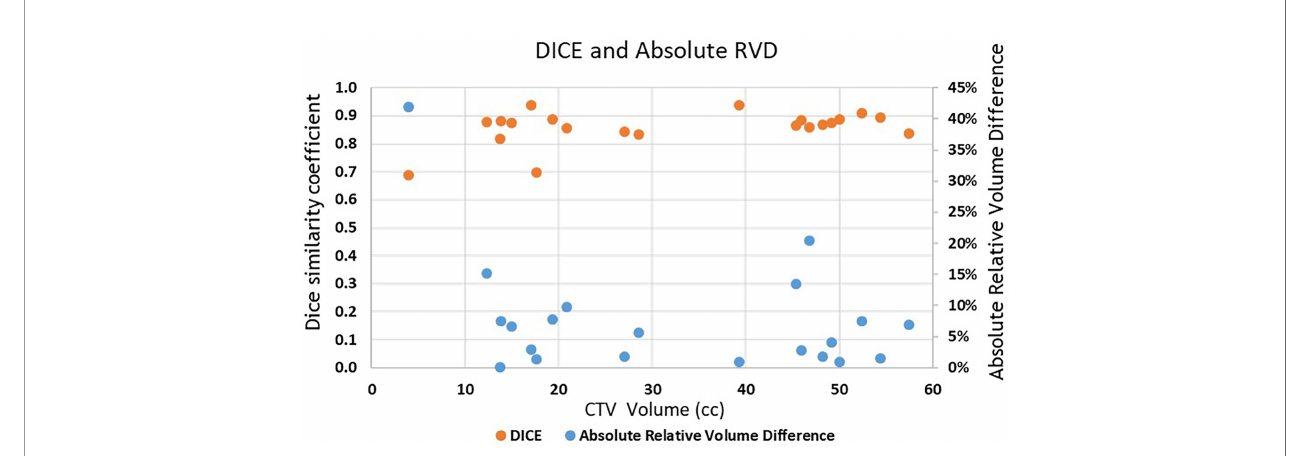
FIGURE 4 | Absolute RVD and DICE of the 21 lesions vs. clinically used CTV volume. Blue dots are Absolute RVD and orange dots